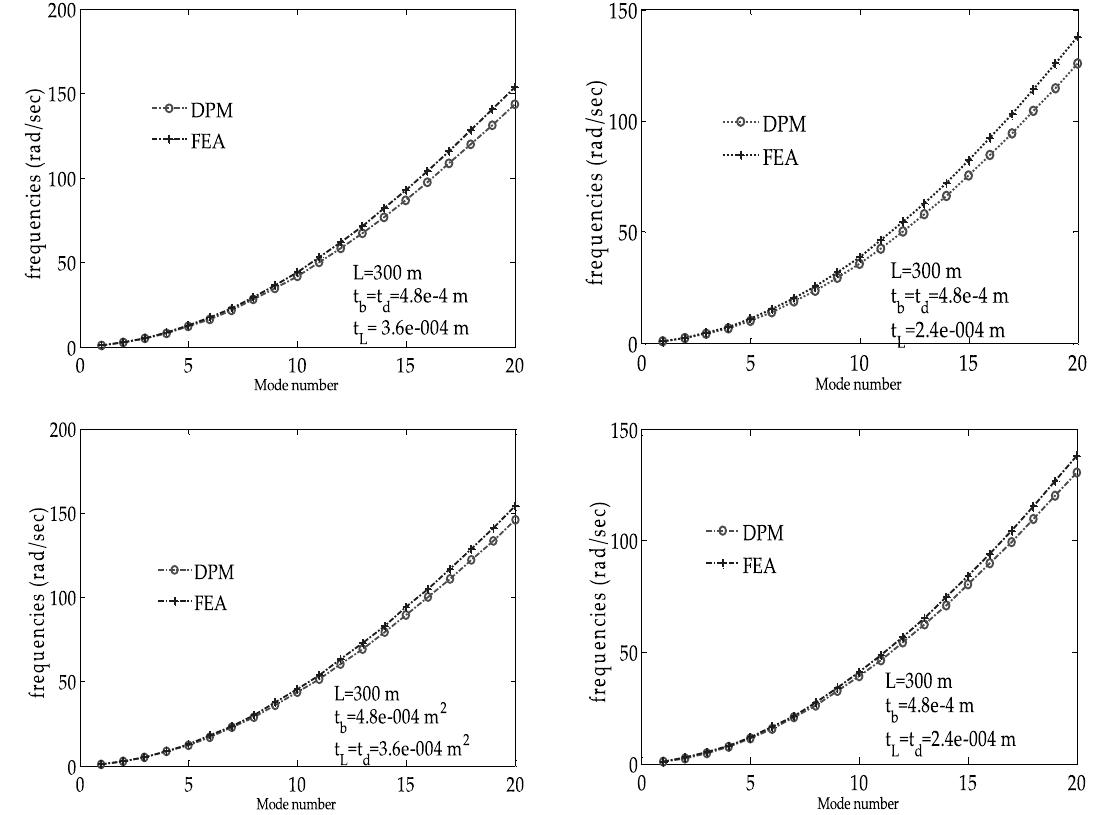
Fig. 8. Frequency comparison of DPM and FEA for satellite truss of various longeron thickness (no actuators- con fi guration